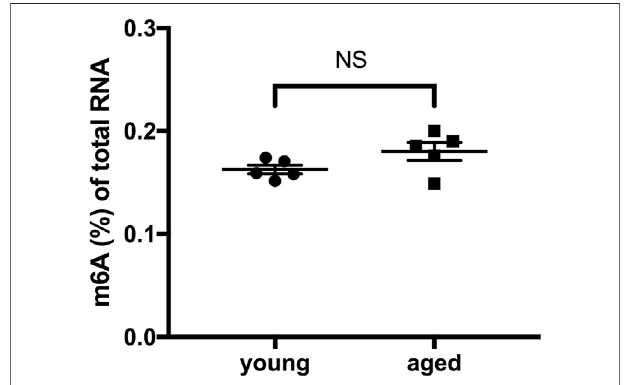
FIGURE 1 | Global m6A RNA methylation in the heart did not differ according to age under physiological conditions. n (cid:1) 5. Results are presented as mean ± standard error of the mean (SEM). NS, p >